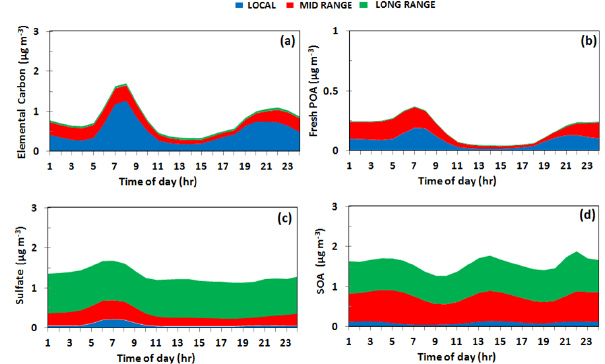
Fig. 2. Average simulated diurnal profiles of PM 2 . 5 components and their sources for the summer period for: (a) elemental carbon; (b) fresh POA; (c) sulfate and (d) SOA.